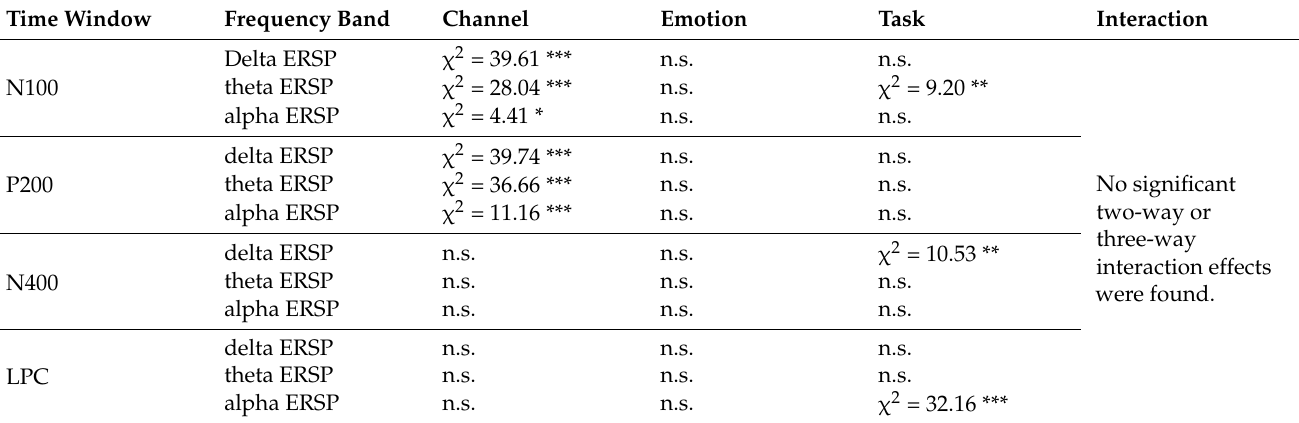
Table 3. Effects that reached significance for ERSP